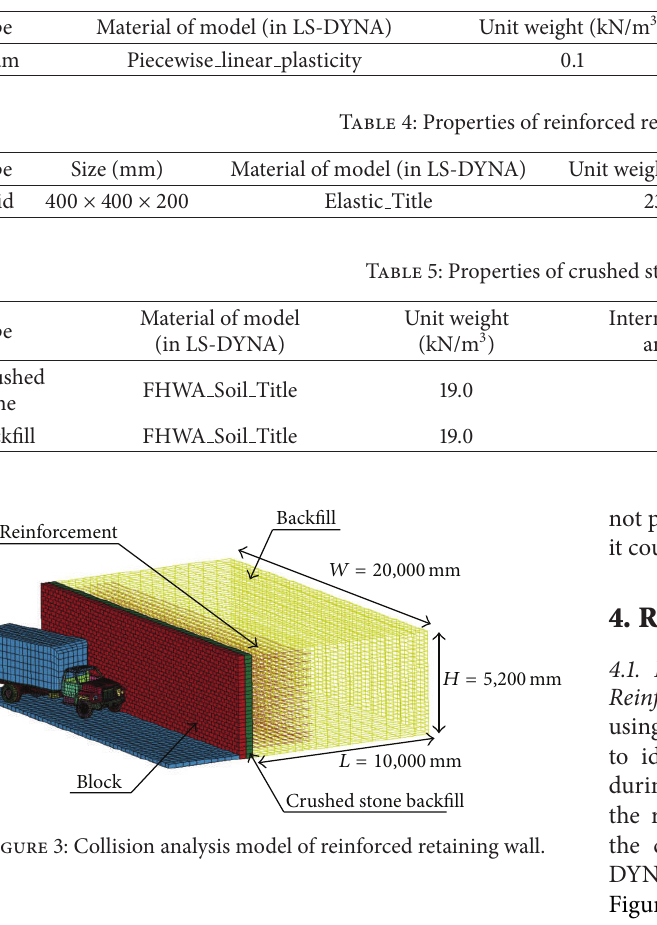
Table 3: Properties of reinforcement.